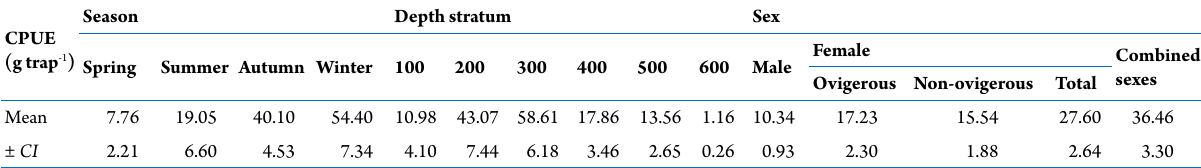
Table 2. Catch per unit effort (CPUE) of Plesionika edwardsii by season, depth and sex in the Azorean region during the period 1999-2000. CI: 0.95 confidence interval. CPUE (g trap -1 )